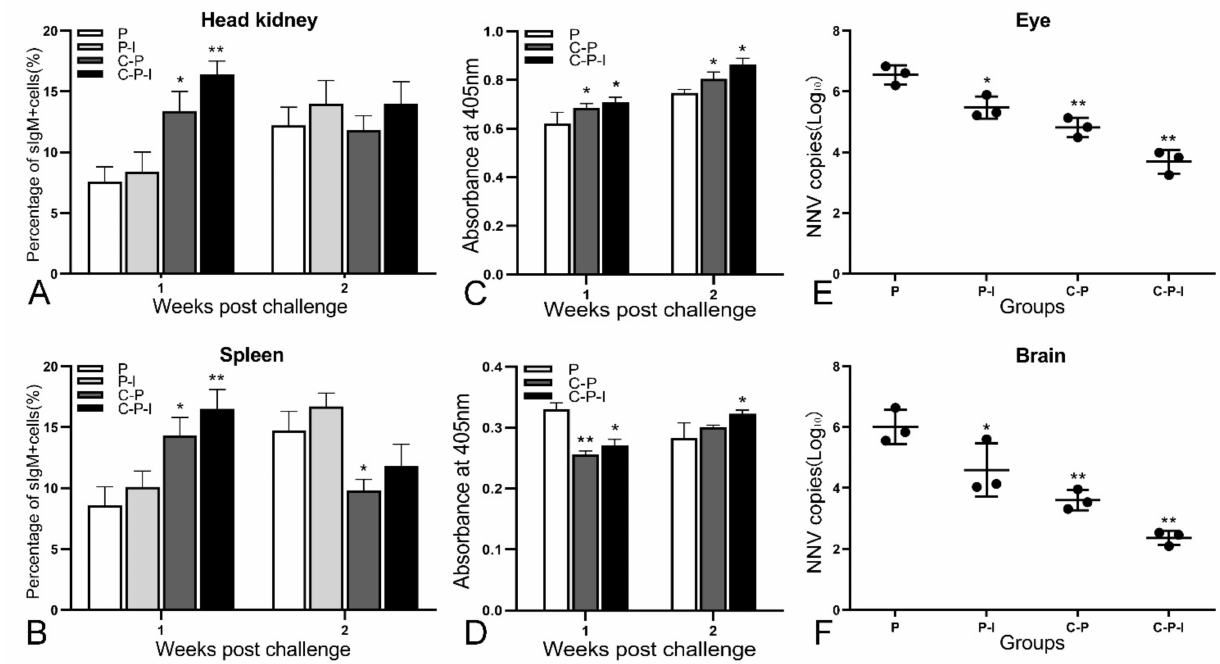
Figure 9. Immune protection provided by vaccination. In 1 × 10 6 TCID 50 /fish group, the changes of percentage of sIgM+ lymphocytes in the head kidney ( A ) and spleen ( B ), the changes of total antibodies ( C ) and specific antibodies against NNV ( D ) in the serum for two weeks. Virus loads in eyes ( E ) and brains ( F ) of vaccinated grouper post-challenge with NNV. Results are expressed in log10 scale with mean viral load and standard deviation. P: pBudCE4.1 group; P-I: pBudCE4.1- IRF3 group; C-P: CP-pBudCE4.1 group; C-P-I: CP-pBudCE4.1-IRF3 group. Results are shown as mean ± standard deviation of values randomly obtained from three fish. Asterisks (*) on the bar represent the statistically significant difference, * p < 0.05, ** p <